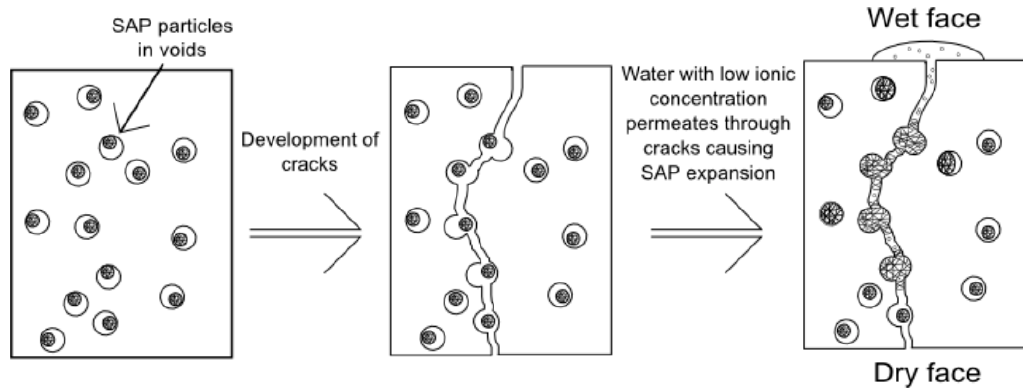
Figure 5. Schematic display of self-sealing of cracks in concrete by using SAPs. Adapted from [146], with permission from © 2010 Taylor & Francis.